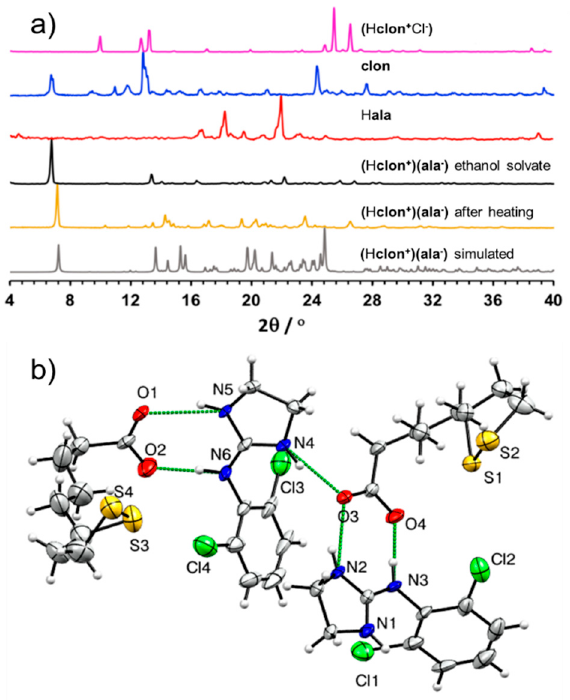
Figure 3. ( a ) Comparison of PXRD patterns for: (Top to bottom): (H clon + Cl − ), solid clon , H ala , product of LAG of clon and H ala in presence of EtOH, the liquid-assisted grinding (LAG) product after heating at 95 °C for one hour and simulated for the herein reported crystal structure of (H clon + )( ala − ); ( b ) view of the asymmetric unit of the (H clon + )( ala − ) salt, illustrating the assembly of cations and anions via N-H···O hydrogen bonds (depicted as green dashed lines). For clarity, only non-carbon and non-hydrogen atoms have been labeled.